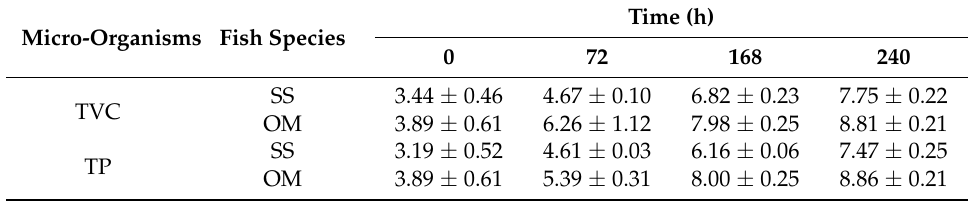
Table 1. Total mesophilic (TVC) and total psychrotrophic (TP) microorganism counts (mean and standard deviation) in Salmo salar (SS) and Onconrhynchus mykiss (OM) samples, according to storage